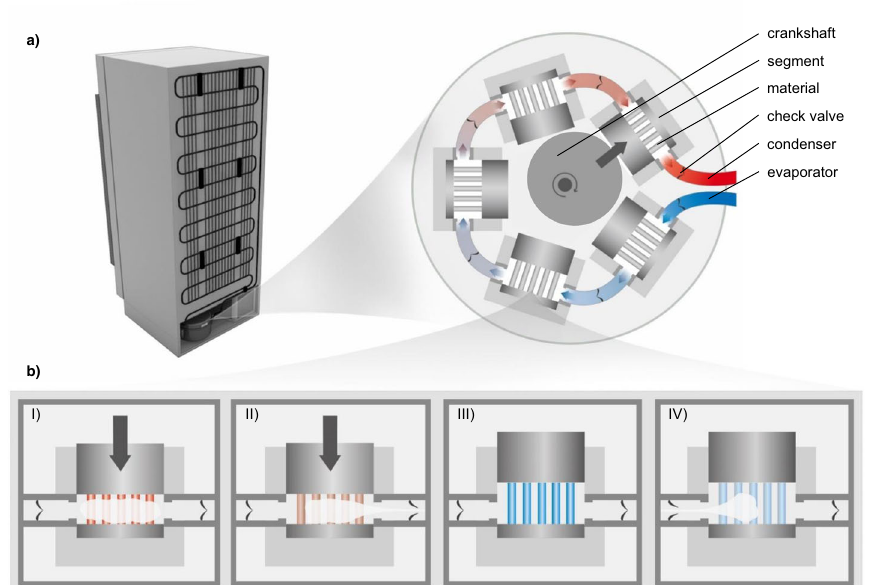
Fig. 2 Functional schematic of an active elastocaloric heat pipe (AEH). a AEH cooling unit of a refrigerator consisting of fi ve segments connected in series between evaporator and condenser. b shows the elastocaloric cycle in only one segment of an AEH: I: The ECM heats up under load. The fl uid on the surface of the ECM evaporates, the vapour pressure in this segment increases. II: Caused by the pressure difference between this segment and the next segment, the right check valve opens. Gaseous fl uid fl ows into the next segment. III: By removing the load, the ECM cools down. IV: Fluid from the gaseous phase condenses, the vapour pressure decreases to a level below the pressure in the previous segment. The left check valve opens and gaseous fl uid fl ows into the